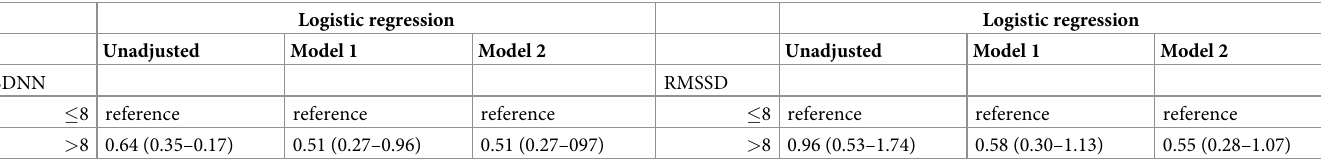
Table 2. Odds ratio for mortality within three weeks after admission using logistic